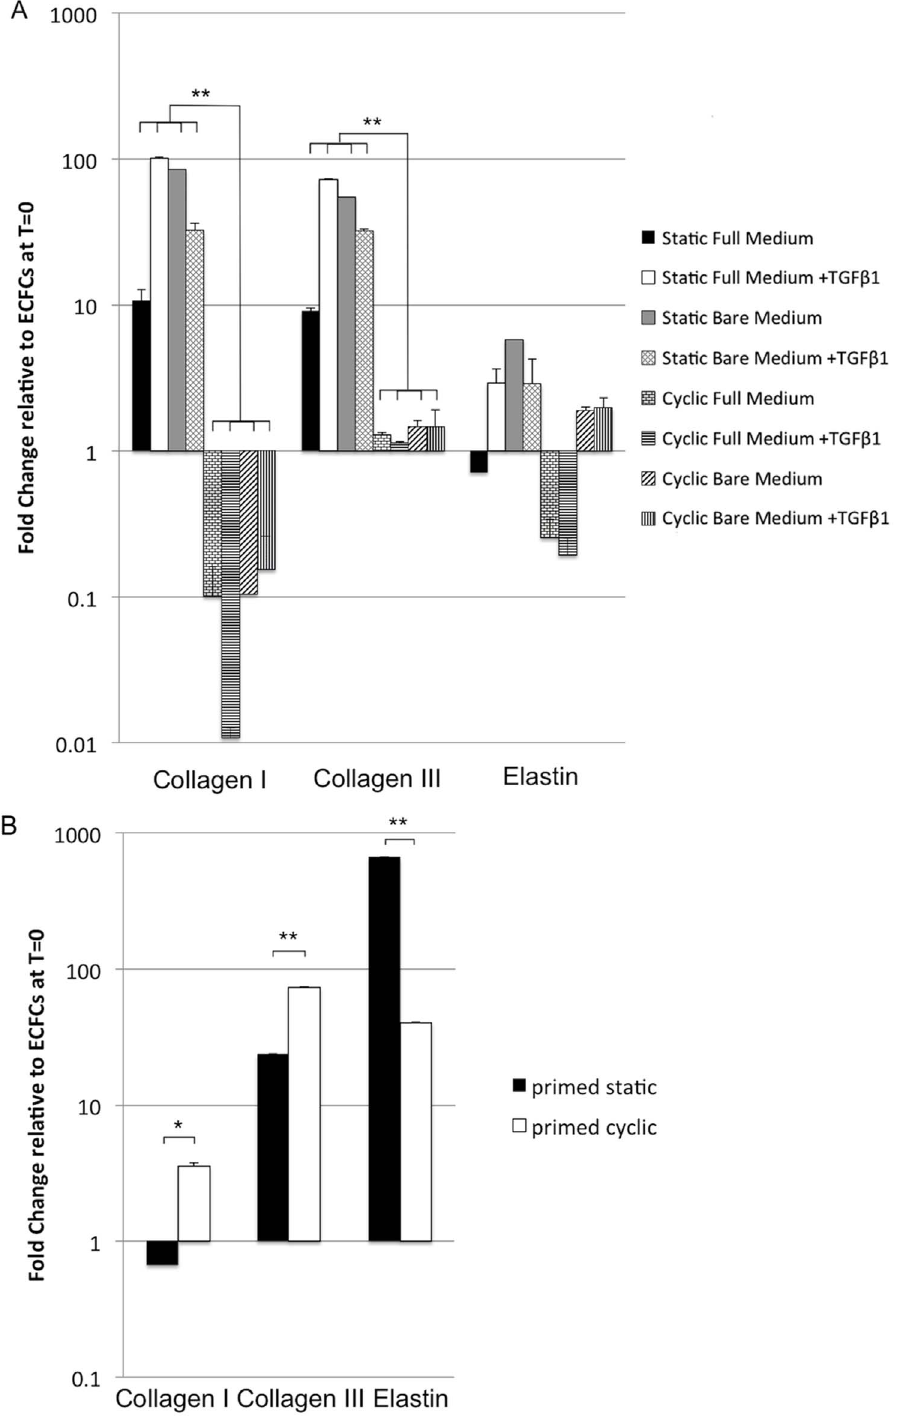
Figure 3. qPCR of ECFCs and primed ECFCs under static and cyclic strain in 3D. Expression of ECM genes is shown relative to primed ECFCs before seeding into the 3D gels. (A) Cyclic strain significantly decreased expression of collagen type I and III in ECFCs for all medium groups. The expression of collagen IV was not detected. (B) Cyclic strain significantly upregulated expression of collagen type I and III in ECFCs primed with TGF b 1. Elastin expression was reduced in these cells in response to cyclic strain. *=p , 0.05, **=p , 0.01, N=3.